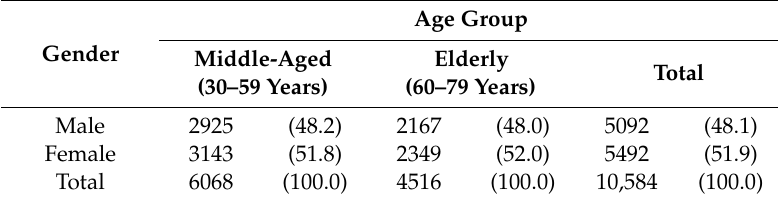
Table 1. Number of persons whose anonymized data were used.